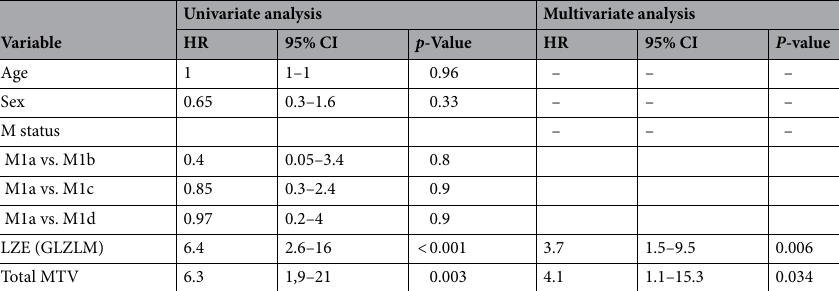
Table 3. Univariate and multivariate cox regression analyses of overall survival in patients with metastatic melanoma. The distribution of each 18 F-FDG PET biomarker is a continuous variable that is transformed into a discrete categorization of 2 categories (high vs. low) using the values derived from the Youden’s index: LZE (≥ − 437 vs < − 437), total MTV (≥ 5.6 vs < 5.6 cm 3 ). HR hazard ratio, CI confidence interval, LZE (GLZLM) Long zone emphasis from the grey-level zone length matrix long-zone, MTV metabolic tumoral volume, NGLDM Neighbourhood grey-level different matrix, TLG total lesion glycolysis, M Metastatic status (8th American Joint Committee on Cancer classification): M1a: distant metastasis to skin, soft tissue including muscles, and/or nonregional lymph. M1b: distant metastasis to lung with or without M1a sites of disease. M1c: distant metastasis to non-central nervous system (CNS) visceral sites with or without M1a or M1b sites of disease. M1d: distant metastasis to CNS with or without M1a, M1b, or M1c sites of disease.